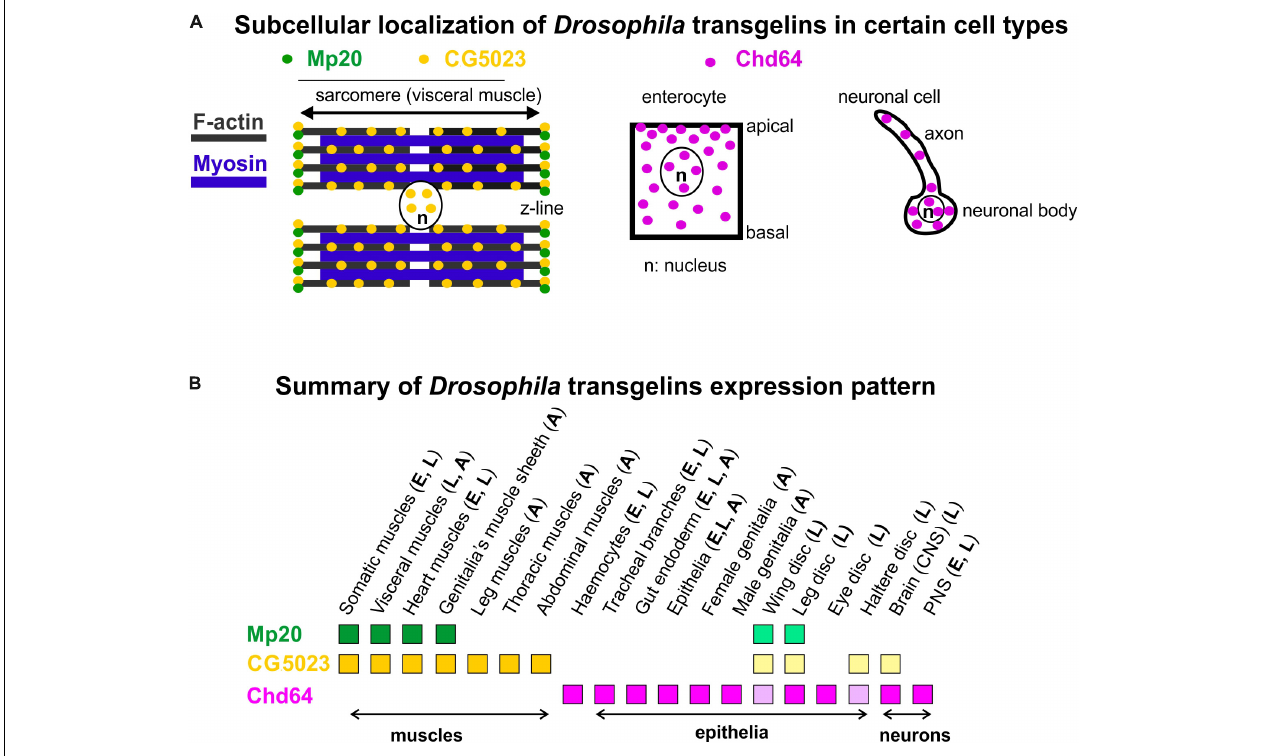
FIGURE 10 | (A,B) Collective schematic representation of (A) subcellular transgelins localization in specific cell types (visceral muscle for Mp20 and CG5023; enterocyte and neuronal cell for Chd64) and (B) tissue expression pattern throughout fly